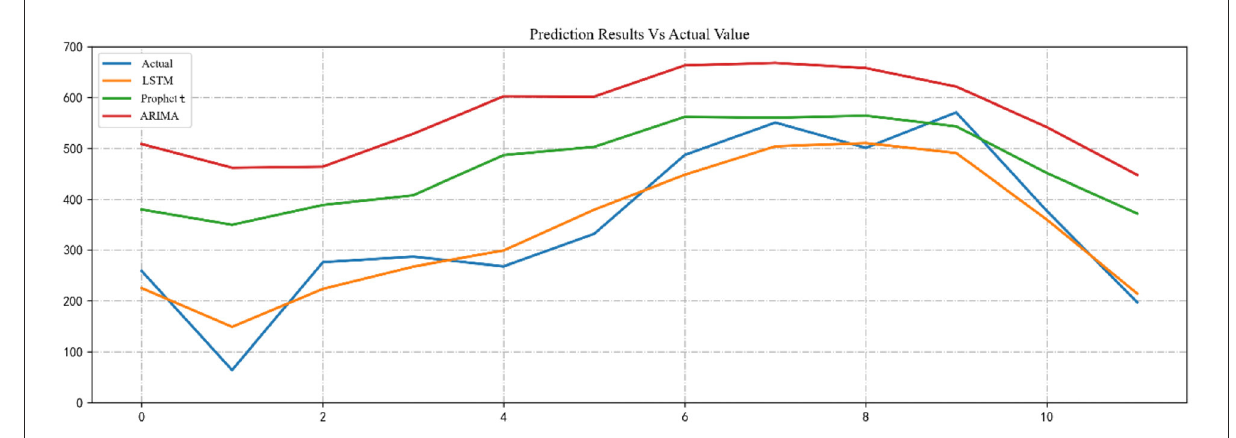
FIGURE7 Visualizations of predicted and actual values for SARIMA, Prophet, and LSTM